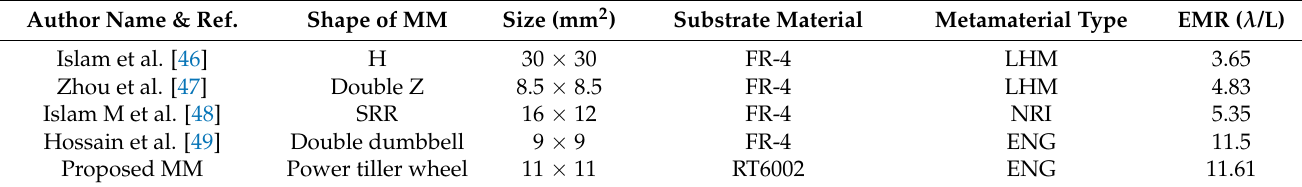
Figure 16. Graph of real and imaginary magnitudes of refractivity for the unit cell. Table 3. Comparison of previously published MMs with the MM proposed in the present